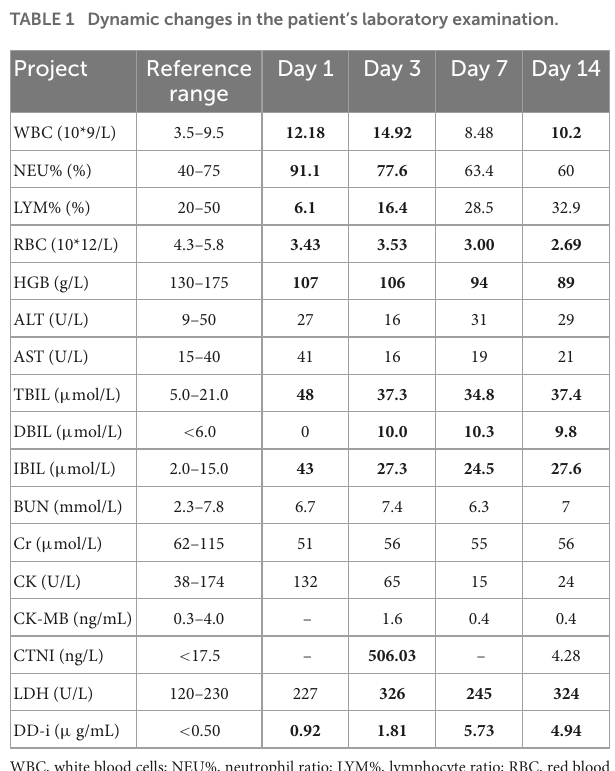
TABLE 1 Dynamic changes in the patient’s laboratory